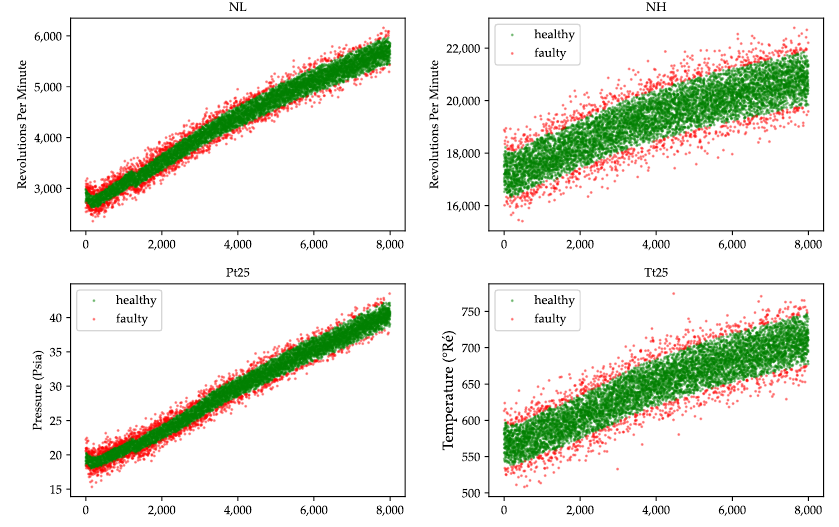
Figure 3. Scatter plot of some sensor data after adding perturbation.